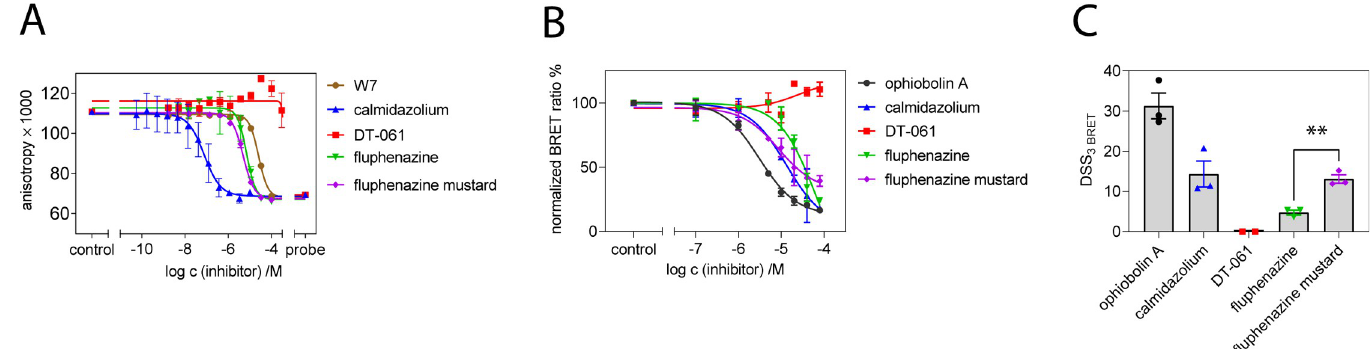
Fig 2. Assessment of the in vitro inhibition of CaM and in cellulo disruption of K-Ras/ CaM binding. (A) CaM inhibition was assessed using 100 nM CaM and displacement of 10 nM F-PMCA CaM-binding peptide by inhibitors using fluorescence polarization measurements. Data represent mean values ± SD, n = 2. (B) Dose- response analysis of indicated inhibitors at 0.1–80 μ M using the Rluc8-K-RasG12V/ GFP2-CaM BRET assay in HEK-293 EBNA cells. The acceptor/ donor plasmid ratio was 9/1. Data represent mean values ± SD, n � 2. (C) DSS 3 BRET i.e. normalized area ’under’ the inhibition curve values (hence, here actually above the curve) of dose response data shown in (B). Statistical analysis was performed using unpaired